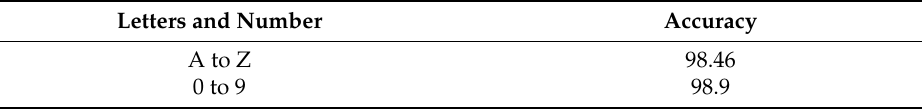
Table 2. Accuracy using Mobile Net.